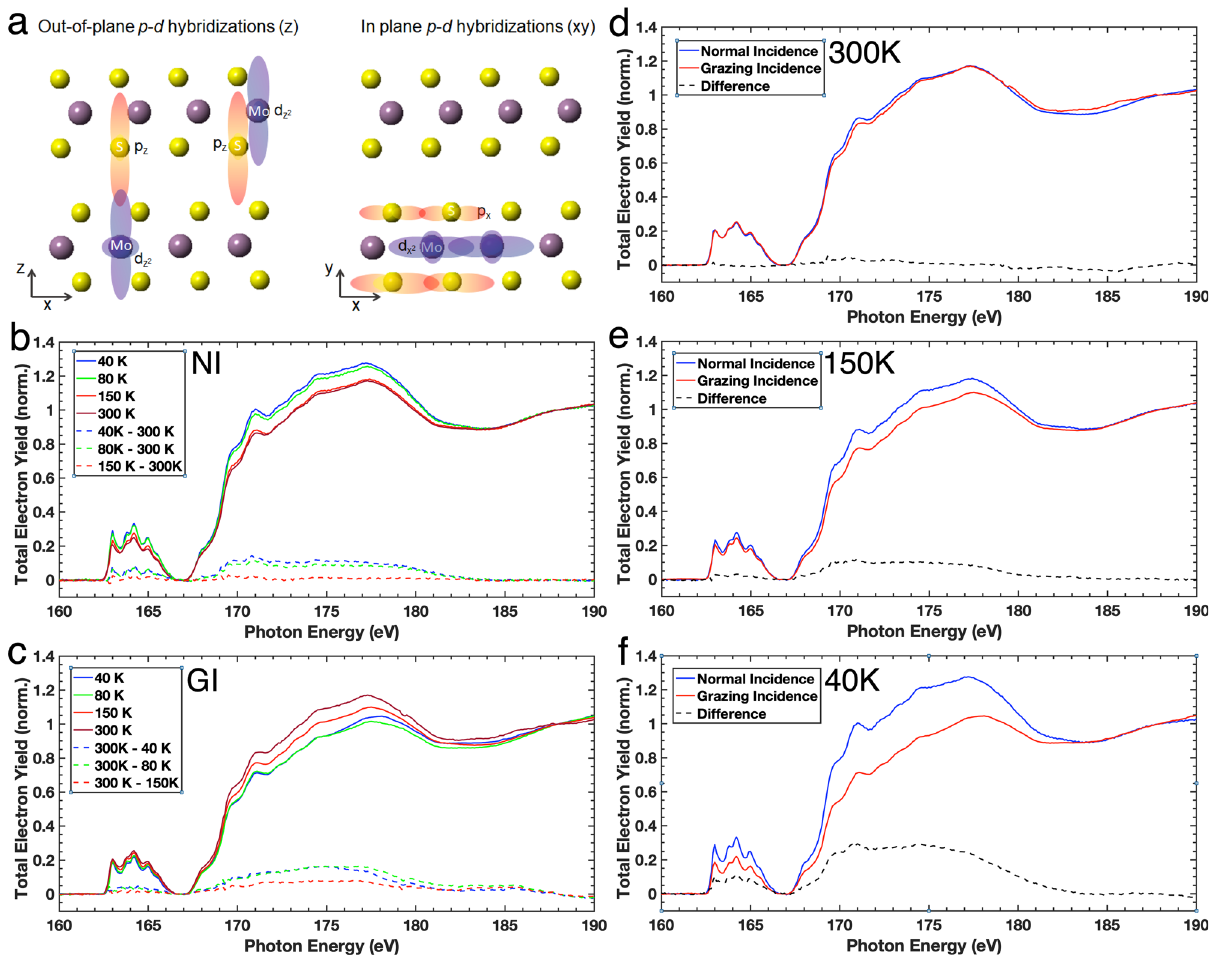
Fig. 4 Temperature-dependent X-ray absorption spectroscopy (XAS) spectra at S L 2,3 edges and their differences with respect to 300 K data on MoS 2 . a A schematic diagram of in-plane and out-of-plane p – d hybridisations in MoS 2 . XAS spectra when the sample is at b normal (NI) and c grazing incidence (GI) angles, respectively, as a function of temperature. d – f Comparison of normal and grazing incidence XAS spectra for 300 K, 150 K, and 40 K,